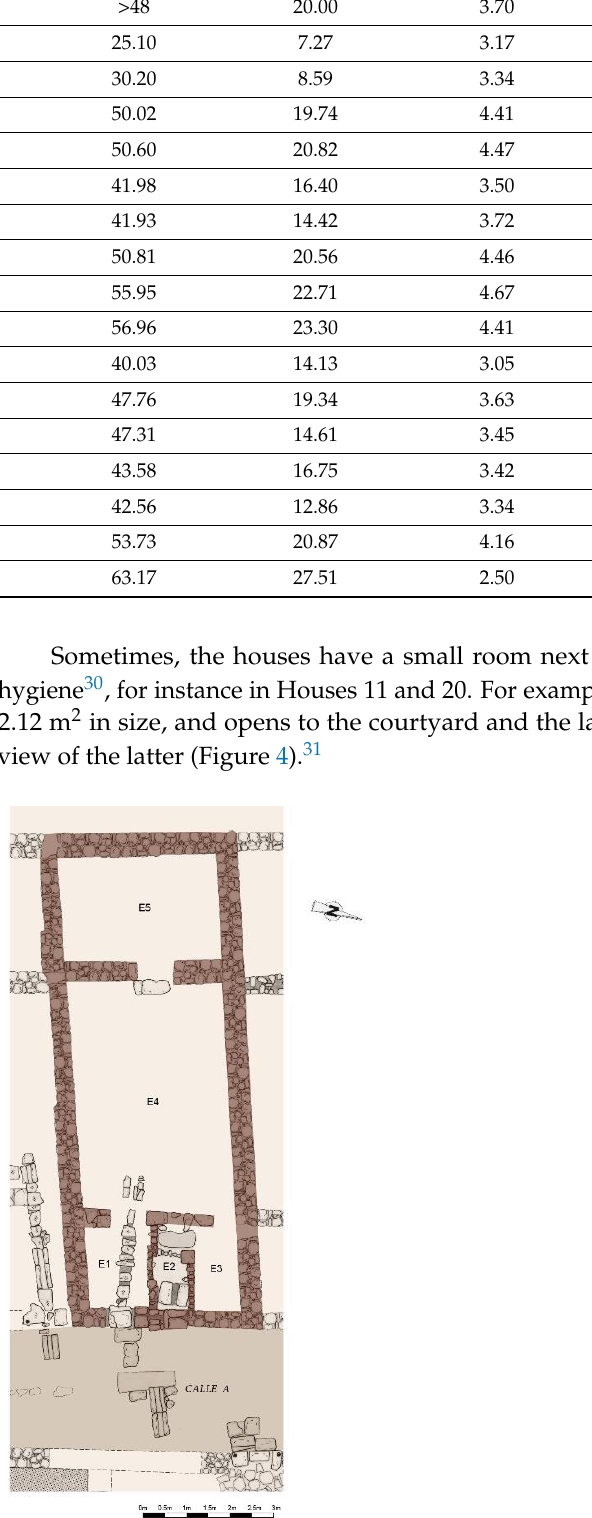
Figure 4. House 11. Latrine with access from a room for personal hygiene (E3).